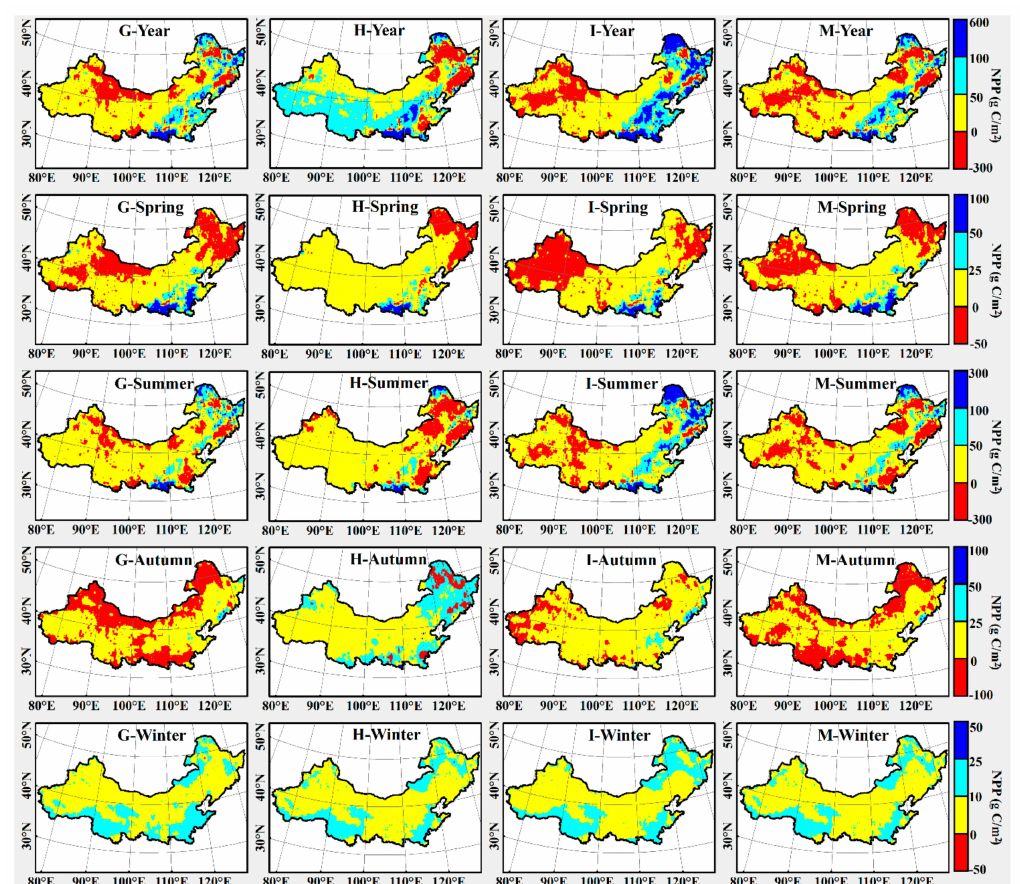
Figure 5. Spatial distribution of NPP changes under GW_1.5 ◦ C for the whole year, spring (March, April, May), summer (June, July, August), autumn (September, October, November), and winter (December, January, February). Each letter represents a di ff erent climate model; G represents the GFDL-ESM2M model, H represents the HadGEM2-ES model, I represents the IPSL-CM5A-LR model, and M represents the MIROC5